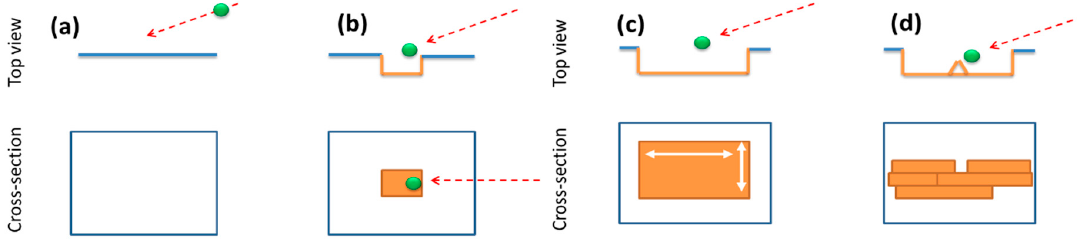
Figure 3. Proposed mechanism of ripple formation during OAE is illustrated. ( a ) Starting Surface, ( b ) Initial roughness formation through its and bumps during random etching, ( c ) Elongation of initial pits due to shadowing effect leading to the formation of valleys, and widening of valleys through re ‐ emission effect, ( d ) Merging of valleys after removal of the hills separating them, and further widening due to the re ‐ emission.